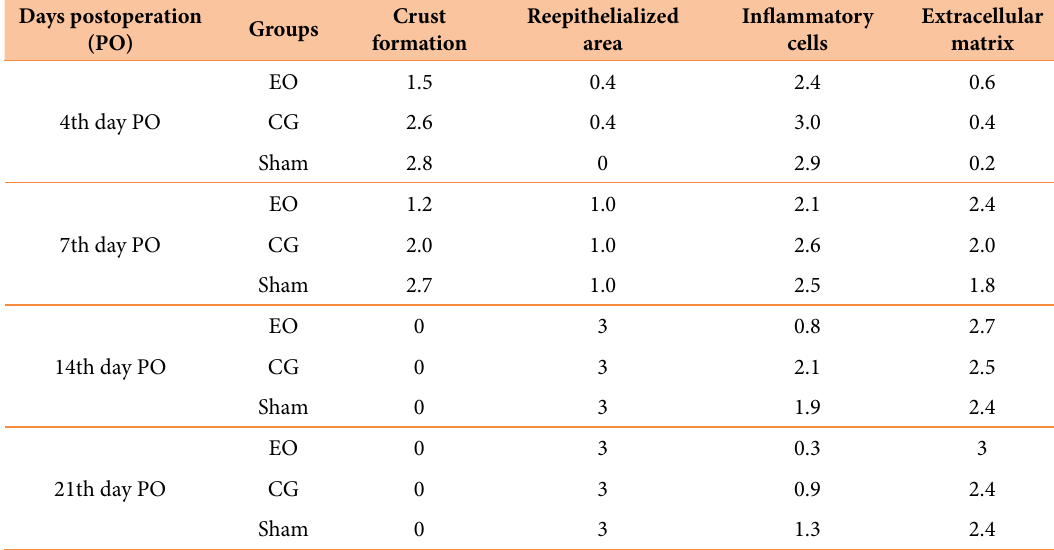
Figure 4 - An increased collagen fibers deposition was noticed in wounds of EO group. (a) Kinetics of the percentage of collagen fibers. (b) Representative photomicrographs of Gomori’s trichrome-stained sections at the 7th postoperative day. Morphologically, collagen fibers presented thicker and more organized in the EO group, as compared to CG and Sham groups. Data are expressed as mean ± SEM, n = 5 for each time point and group. ** p < 0.01 – EO group versus CG; ***p < 0.001 – EO group versus Sham at the 7th postoperative day, and *p < 0.05 – EO group versus CG and Sham at the 14th postoperative day. Two-way ANOVA. Scale bar: 200 μ m. Table 2 - Mean scores of the histomorphological evaluation of skin wounds in rats at days 4, 7, 14, and 21 after operation. Group treated with essential oil from L. gracilis leaves (EO), control group treated only with vehicle solution (CG) and Sham group, which received no